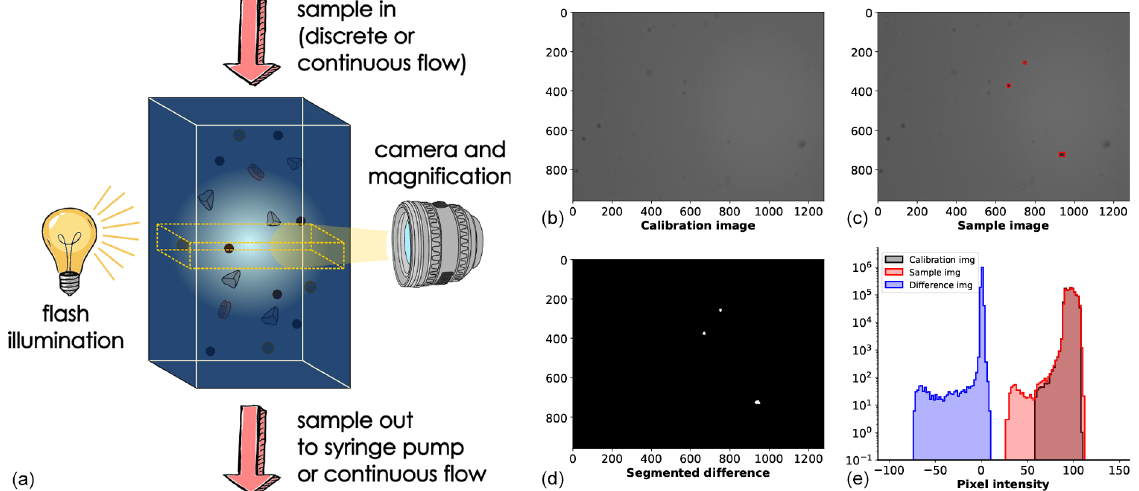
Figure A1. The experimental setup (a) is presented alongside the segmentation of particle images (b–e) . A calibration image of the camera view is obtained prior to the analysis when no sample is pumped into the system (b) . During the analysis, each frame (c) is compared to the calibration image, and a pixel-by-pixel difference is calculated (e) and thresholded to extract the single particle images. This procedure is performed by the FlowCam